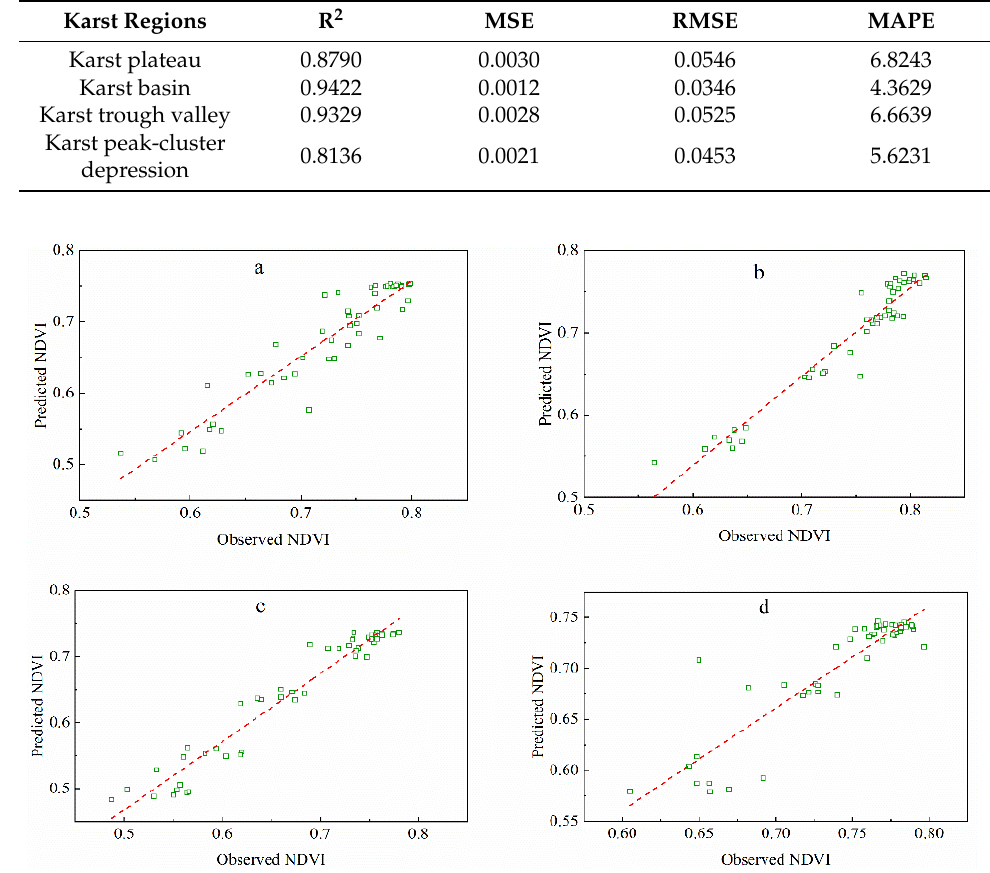
Figure 5. Comparison of the observed and RF predicted NDVI in the ( a ) karst plateau, ( b ) karst trough valley, and ( c ) karst basin, ( d ) karst peak-cluster depression.